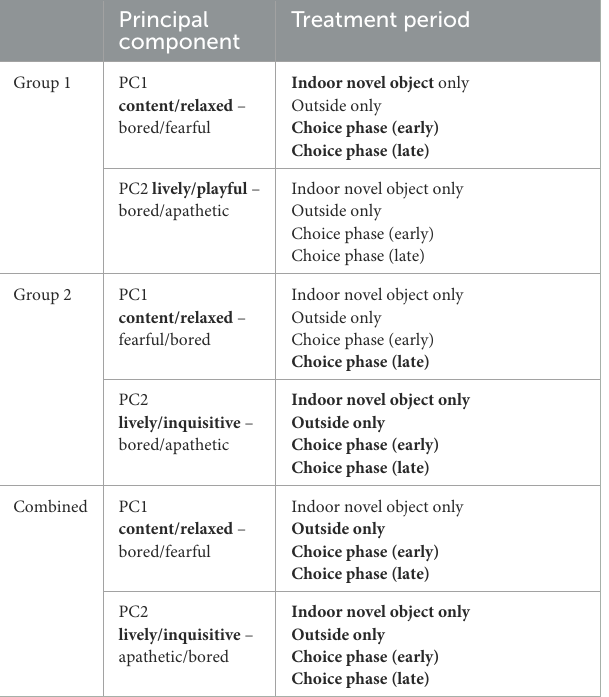
TABLE 7 Summary of results displaying PC1 and PC2 for each group and their associated most positive and negative correlating adjectives. Principal